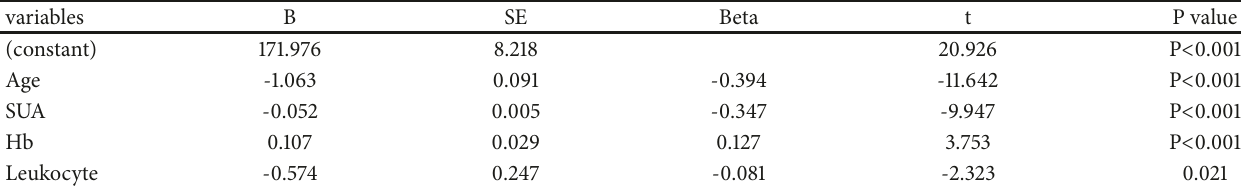
Table 7: Multiple linear stepwise regression analysis for association between eGFR and SUA in female